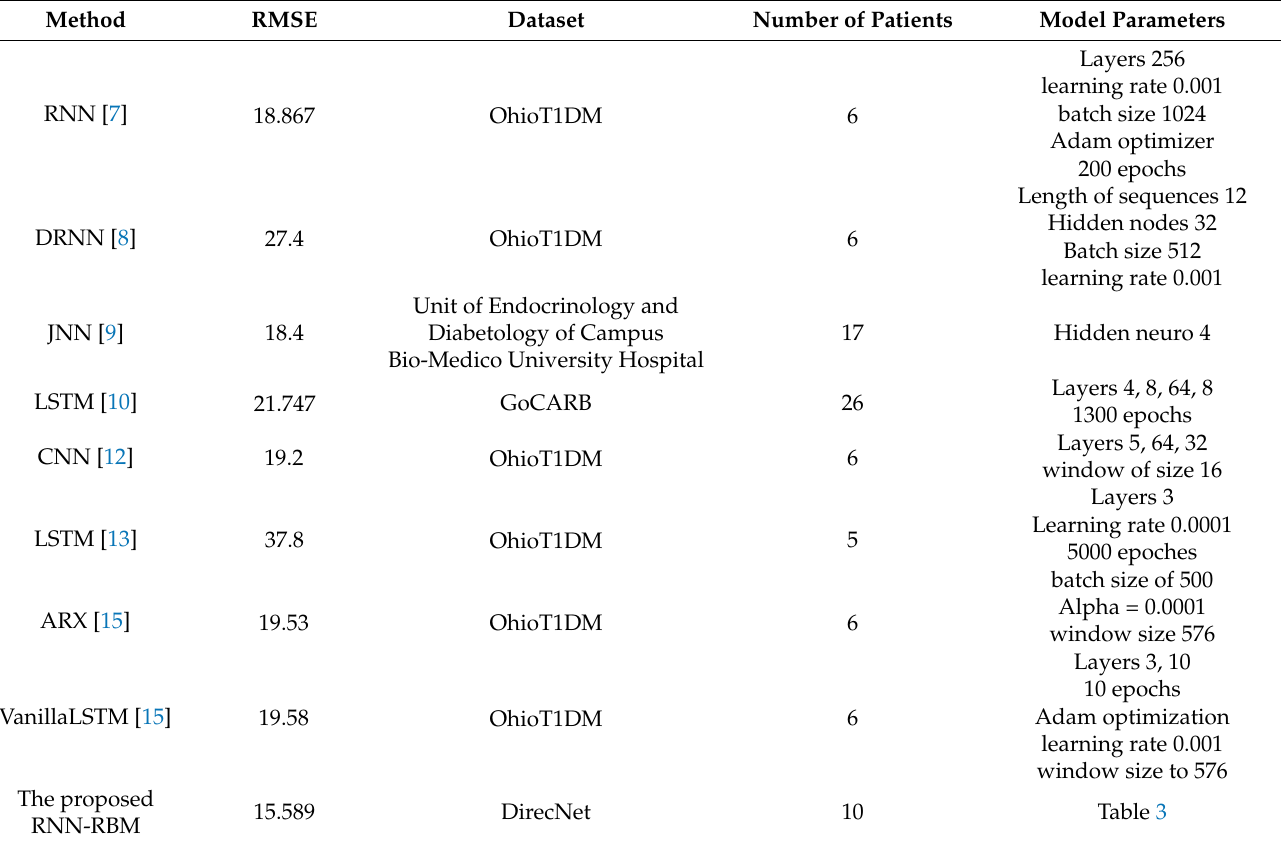
Table 5. Comparison between the proposed RNN-RBM method results and the other well-established methods in the